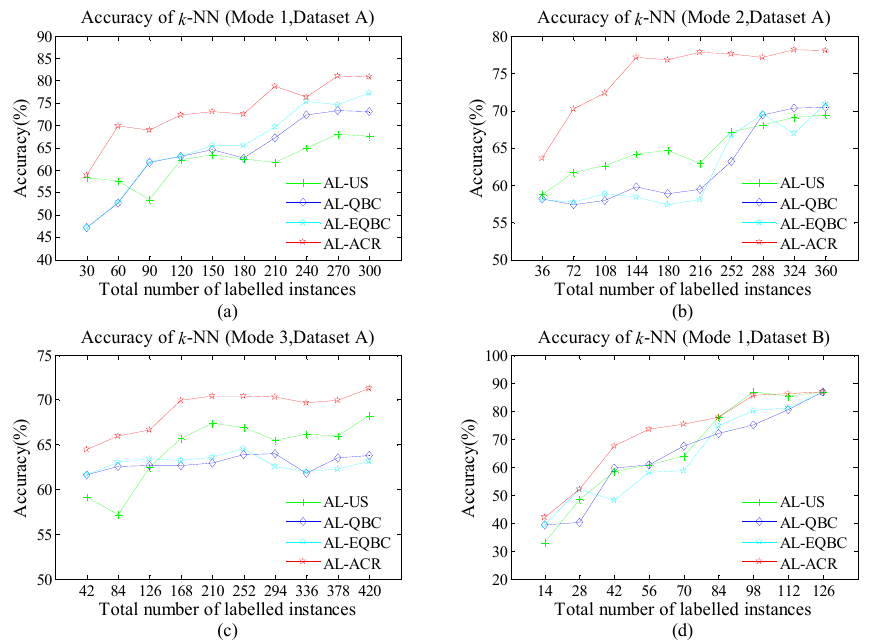
Figure 4. ( a ) Accuracy of k -nearest neighbour ( k -NN) (Scenario 1); ( b ) Accuracy of k -NN (Scenario 2); ( c ) Accuracy of k -NN (Scenario 3); ( d ) Accuracy of k -NN (Scenario 4).